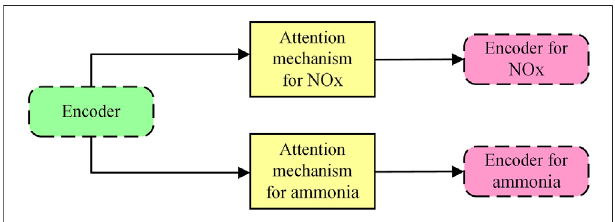
FIGURE 2 | Basic structure of denitri fi cation